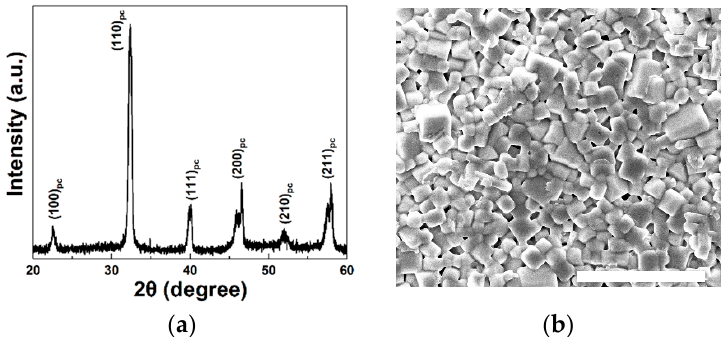
Figure 1. ( a ) XRD pattern, ( b ) SEM image for the surface morphology of BNT-6BT ceramics.